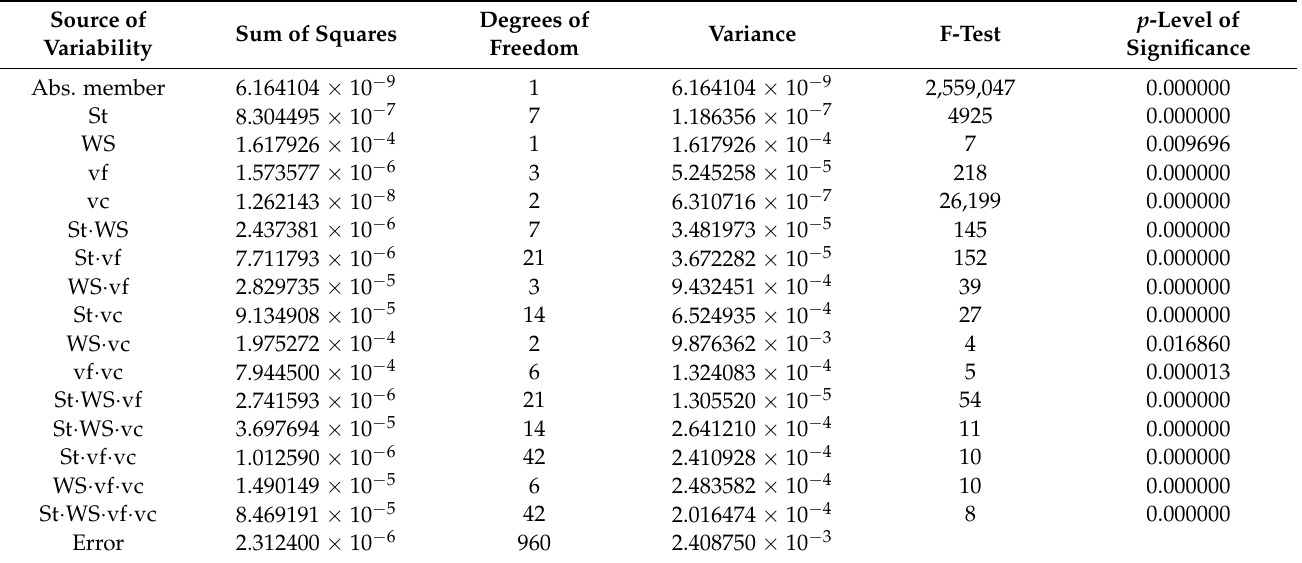
Table 6. Basic table of multifactor analysis of power variance depending on coating, cutting and feed speed and wood